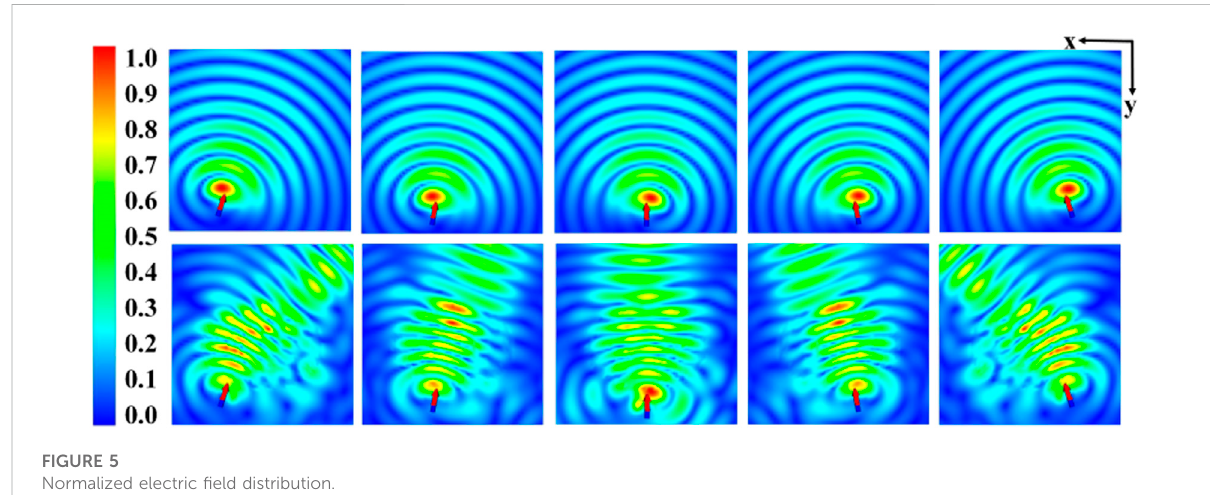
FIGURE 5 Normalized electric fi eld distribution.